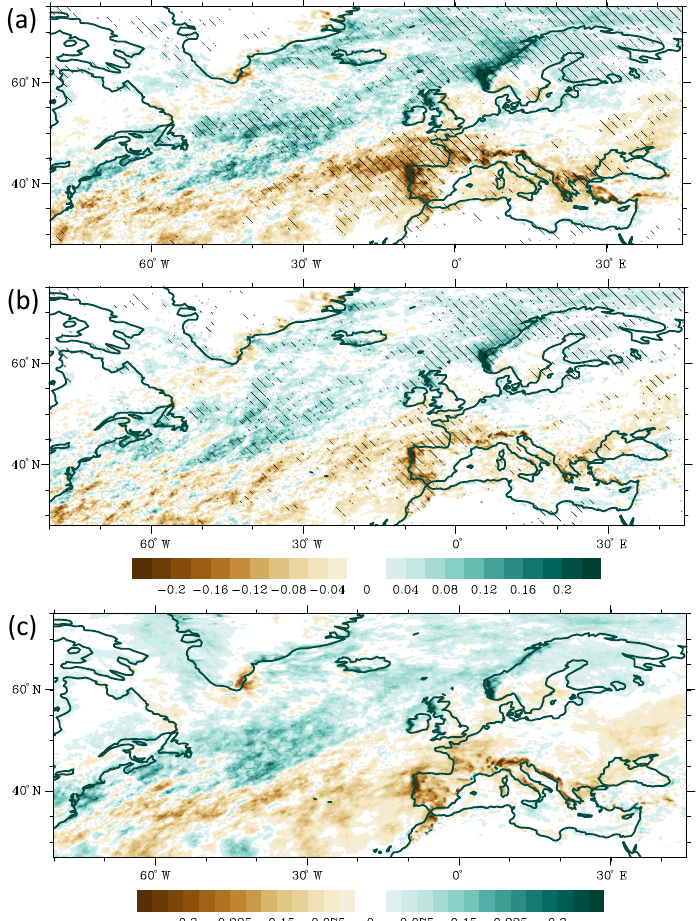
Figure 6. Difference between + 2 and + 1.5 ◦ C ensemble experiments for DJF (a) 95th percentile of 3-hourly precipitation, (b) 95th percentile of daily precipitation (mmh − 1 ) and (c) 10-year return values in 3h precipitation CAM5.1.2_0.25. Percentiles and return values are derived from the samples with values larger than 1mmday − 1 . Regions in (a) and (b) are stippled for differences significant at the 10%